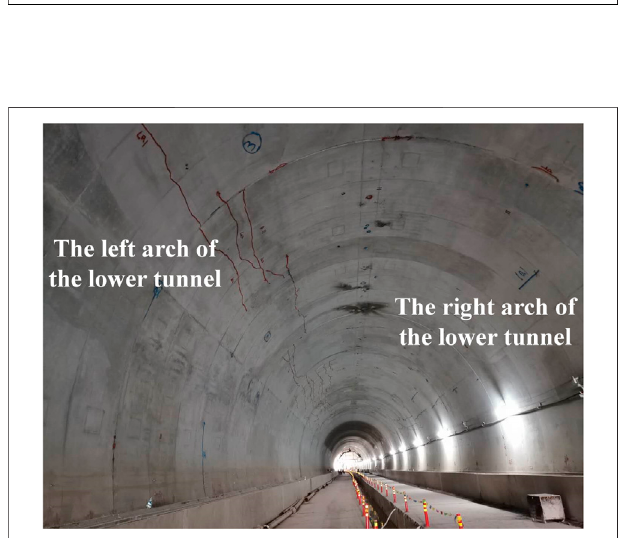
FIGURE13| Sitephotosoflongitudinalcracksontheleftand rightsides of the lower tunnel.